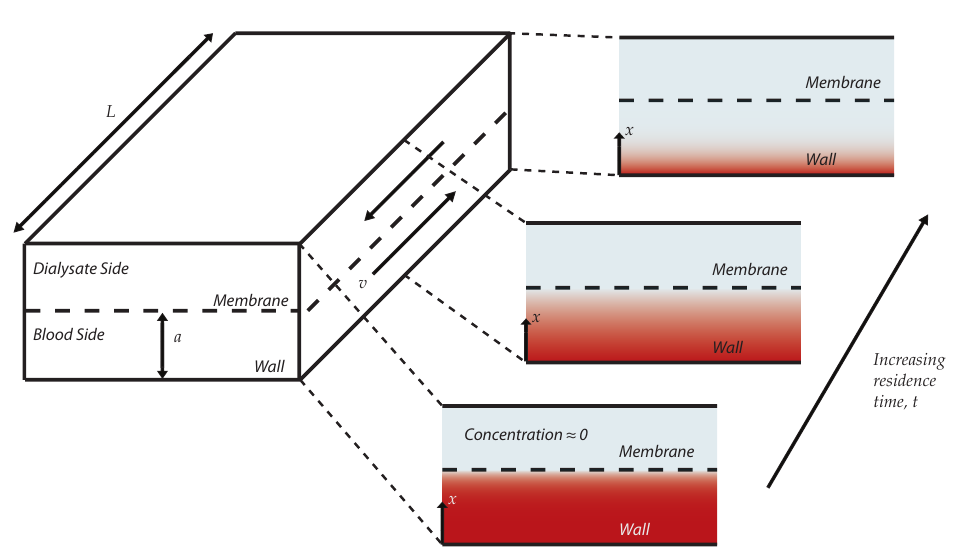
Figure 1. Diagram of system considered by the analytical models. The system is initially at some constant concentration (depicted as red shading) and becomes less concentrated in a gradient over